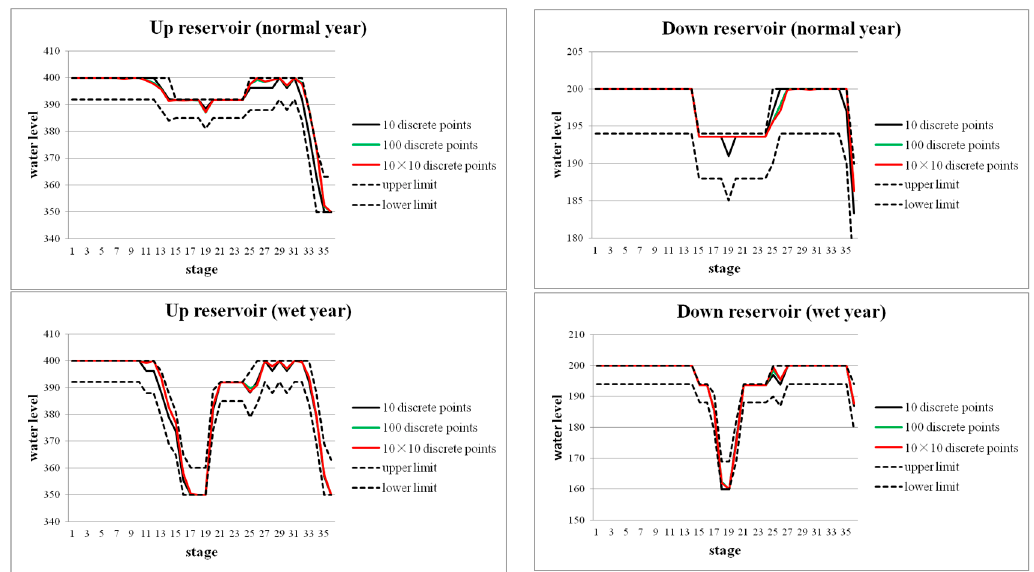
Figure 6. Storage water level variations of scheme “IMDP: 10 × (40/4)”.